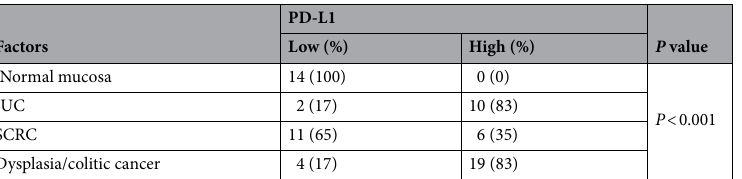
Table 1. Expression of PD-L1 in the respective colon tissues. UC ulcerative colitis, SCRC sporadic colorectal cancer. a Normal mucosa indicates the corresponding non-cancerous tissue in sections with SCRC. b UC indicates the corresponding non-cancerous tissues in sections with dysplasia/colitic cancer.